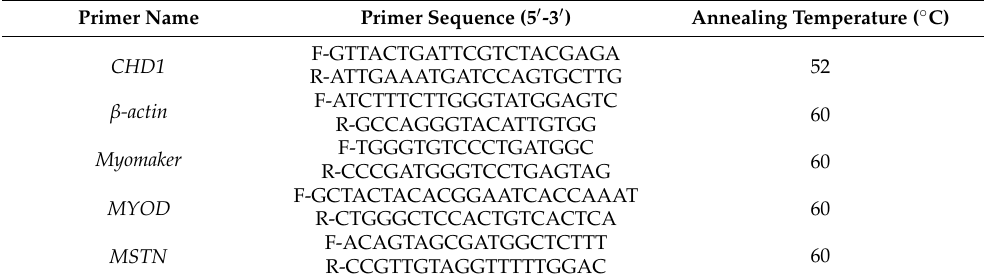
Table 1. The RT-qPCR primer sequence of